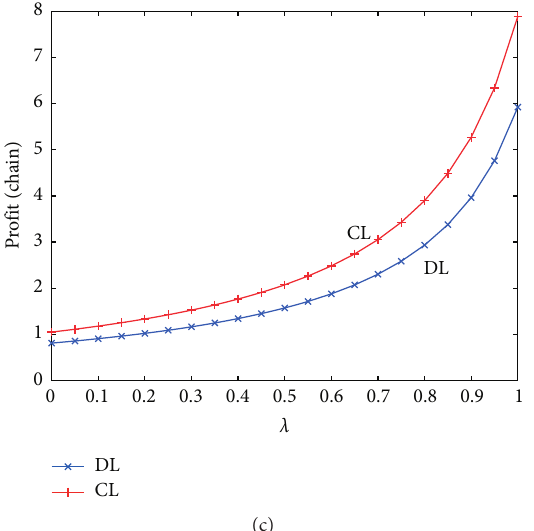
Figure 2: The impact of regret sensitivity coefficient on profits in the supply chain: (a) manufacturers’ profits, (b) retailers’ profits, and (c) the total profits of supply